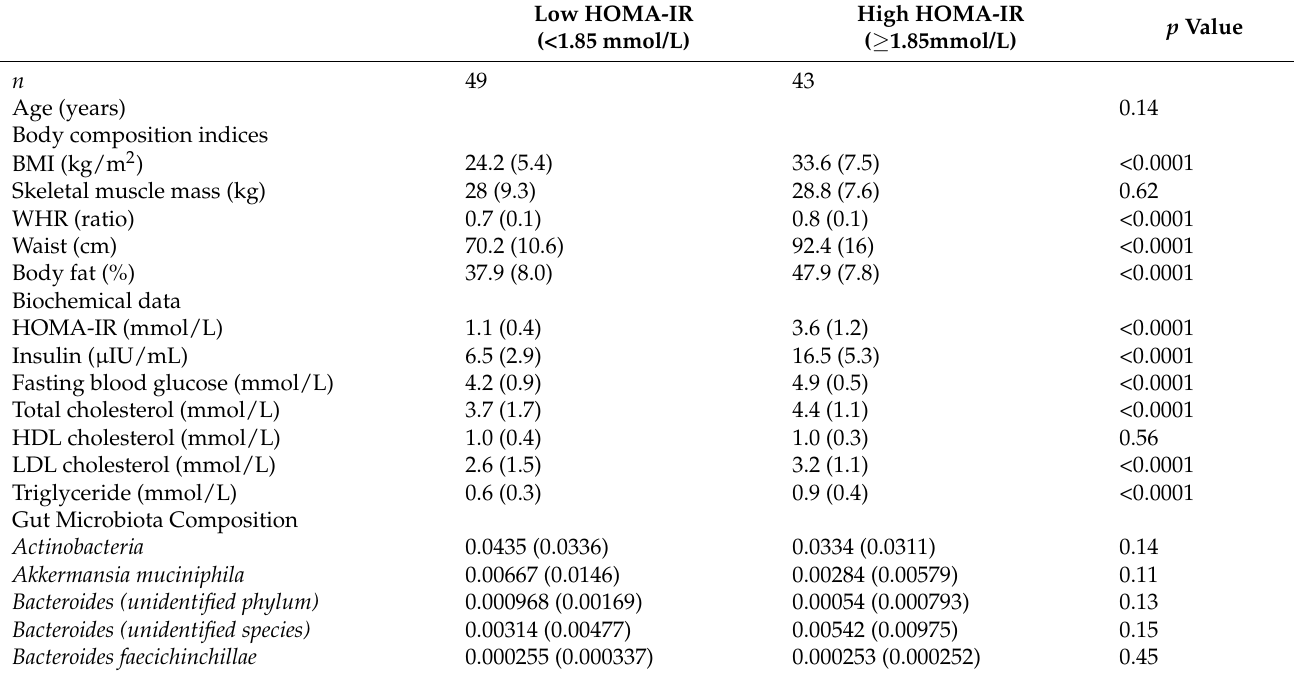
Table 2. Correlation between gut microbiota and glycemic control *.